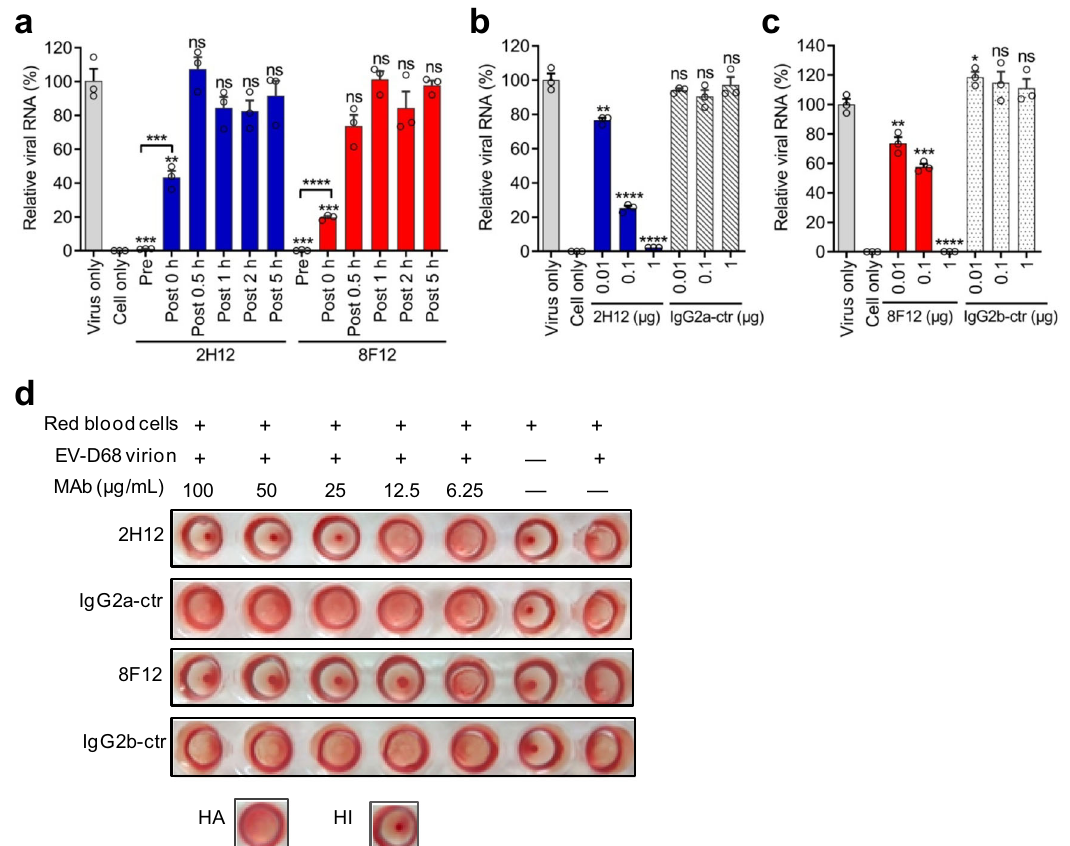
Fig. 3 Anti-EV-D68 MAbs inhibited viral attachment and infection of cells. a Pre- and post-attachment inhibition assays. 1000 TCID 50 of strain 18947 was exposed to the MAbs (2H12 or 8F12) before (pre-attachment, [Pre]) or at different time points after (post-attachment, [Post]) the virus was allowed to adsorb to cooled cells. Total RNA was isolated at 8 h after infection, and EV-D68 RNA was determined by real-time RT-PCR. b , c Inhibition of virus attachment by MAbs 2H12 and 8F12. 1.0 × 10 7 TCID 50 of strains 18953 ( b ) or 18947 ( c ) were pre-incubated with various amounts of the indicated antibodies (anti-EV-D68 MAbs 2H12 and 8F12, or isotype control MAbs) for 1 h prior to binding to prechilled RD cells at 4 °C for 1 h. After washing, cells were harvested and total RNA was isolated for real-time RT-PCR analysis of RNA contents of cell-bound virus. For each treatment in panels ( a – c ), viral RNA levels relative to those for the only virus-infected group are shown. Data are mean ± SEM of triplicate wells. Each symbol represents one well. Statistical signi fi cance between virus-only and treated groups was determined by a two-tailed Student ’ s t -test and was indicated as follows: ns, no signi fi cant difference ( p ≥ 0.05); *, p < 0.05; **, p < 0.01; ***, p < 0.001; ****, p < 0.0001. In panel ( a ), p value between the Pre groups and the virus-only group is 0.0001. In panel ( b ), for the 0.01- μ g 2H12 group, p = 0.0042. In panel ( c) , for the 0.01- μ g 8F12 group, p = 0.0084; for the 0.1- μ g 8F12 group, p = 0.0005. d Dose-dependent hemagglutination inhibition (HI) by anti-EV-D68 MAbs 2H12 and 8F12. The assay relies on hemagglutination (HA) activity of EV-D68 virion (strain 18947). Symbol ( + ) indicates presence; ( − ) indicates absence. In Panels ( b – d ), ZIKV-speci fi c MAb 1C11 and HCV-speci fi c